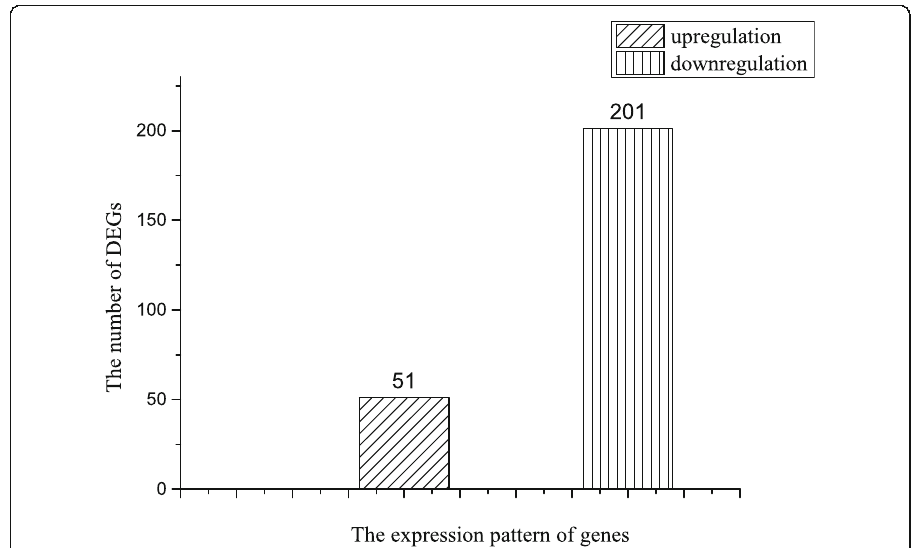
Of all the DEGs, 51 were upregulated in breast cancer tissues (Additional file 3: Table S3).